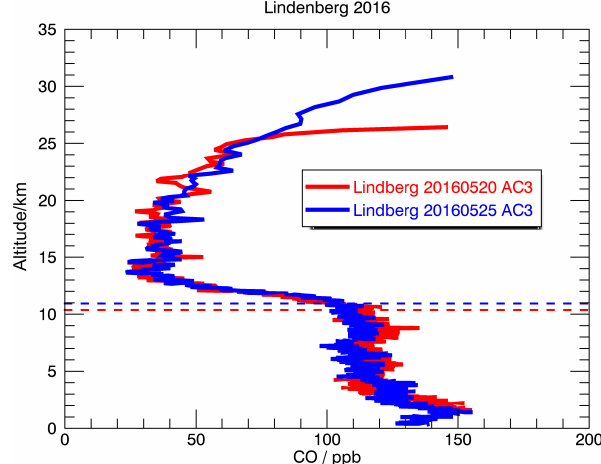
Figure 7. Vertical profiles of CO 2 derived for the flight on 23 Au- gust 2015 from Timmins, Ontario, Canada. The overall structure is captured very well by all AirCores. Again, a finer structure is ob- vious in high-resolution AirCore. See text for discussion of the dif- ferences between the different AirCores. The dashed lines represent the thermal tropopause according to the WMO definition.